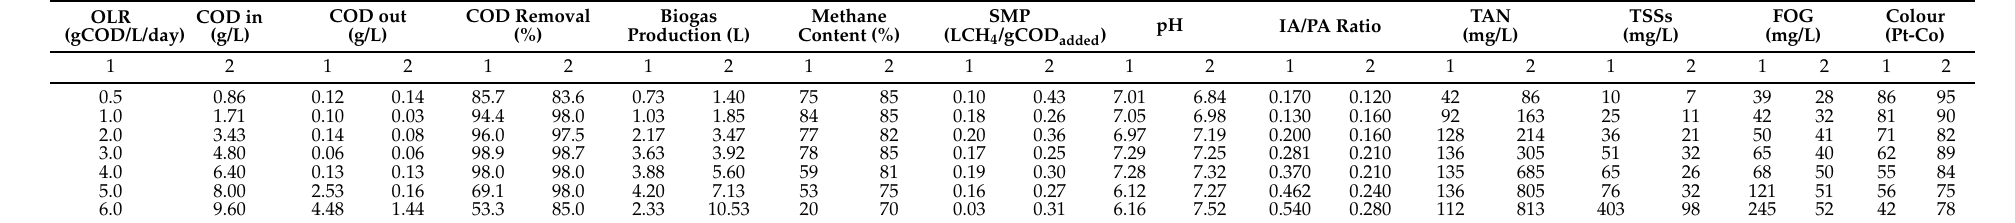
Table 4. Summary of UASB 1 and UASB 2 performance